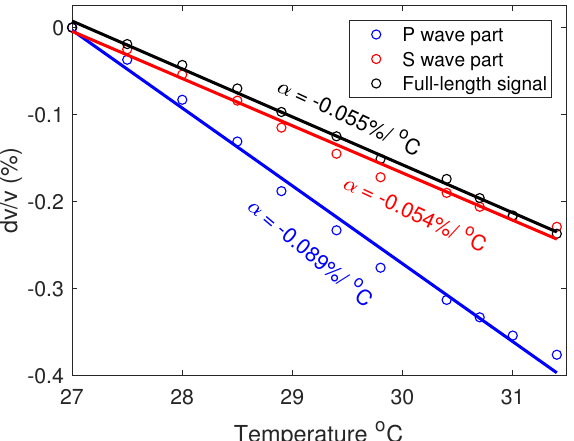
Figure 8. Relative velocity changes of P and S waves with temperature.